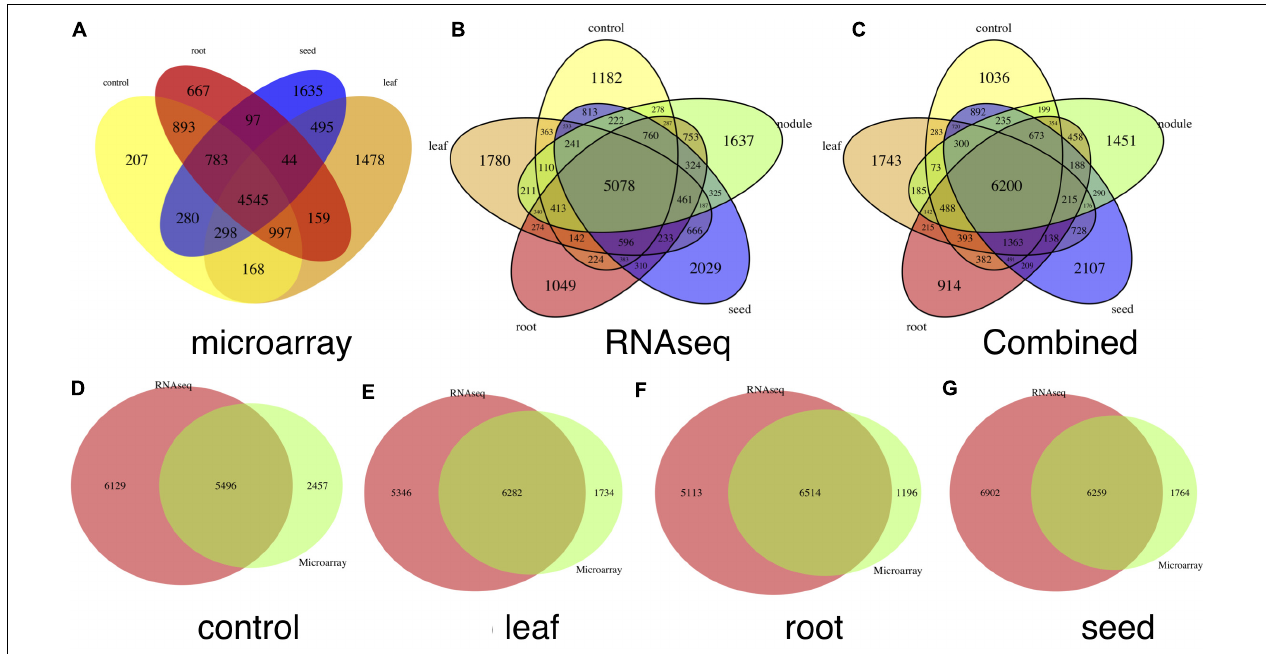
FIGURE 2 | Venn plots of tissue-specific genes. (A) Number of tissue-specific genes in each tissue and control condition detected in the microarray data sets, (B) numbers of issue-specific genes in each tissue and control condition in the RNA-seq data sets, and (C) number of issue-specific genes in each tissue and control condition in combination with (A,B) . (D–G) Show common and tissue-specific genes detected in both microarray and RNA-seq data sets in control, leaf, root, and seed tissues,